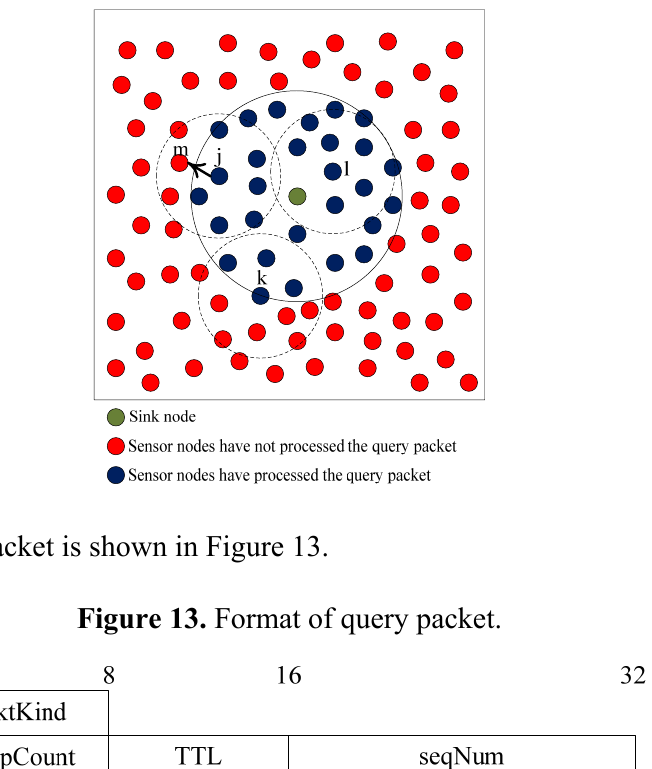
Figure 12. Upon receiving the query packet, nodes make decisions on how to process the packet based on p . The periphery of diffusion area is shown by full curve. The communication areas of nodes are shown by virtual curves.